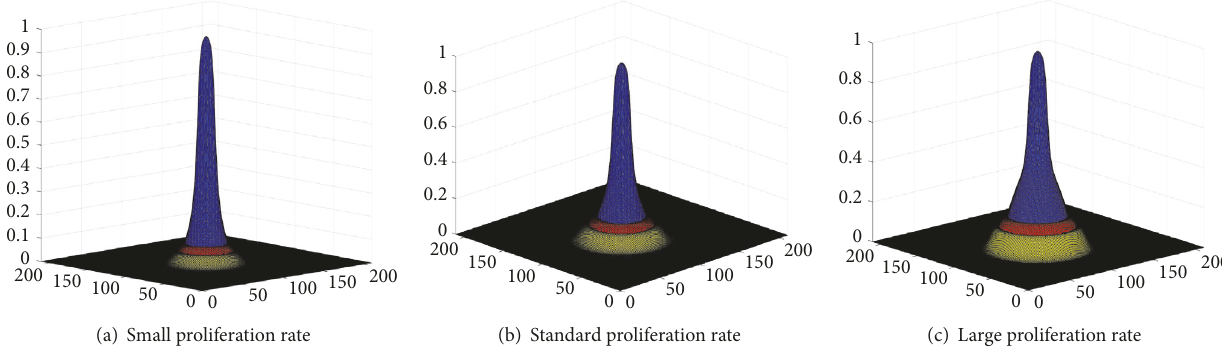
Figure 12: Impact of proliferation rate: (a) 𝛽 = 0.4 , (b) 𝛽 = 0.5 , and (c) 𝛽 = 0.6 . For all three simulations, 𝑡 = 20 .